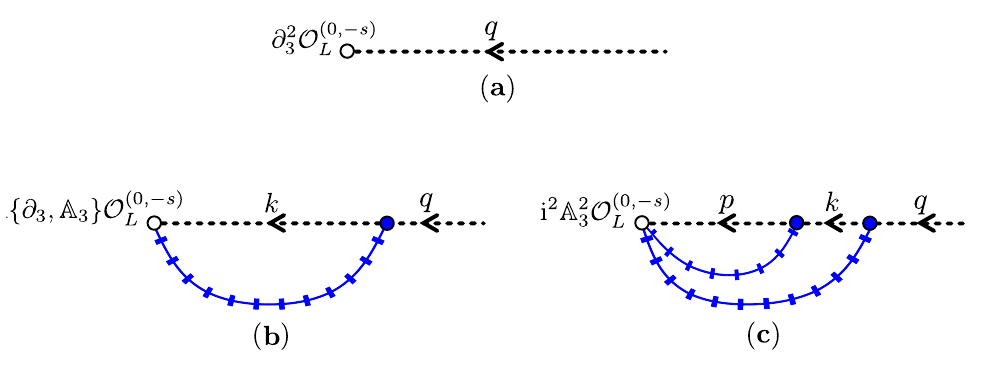
. Here, the gauge field is δ 2 3 O (0 , − s ) L (cid:0) (cid:1) + (cid:0) (cid:1) A A = ∂ . O L A 3 ∂ 3 O L 3 , 3 }O L 3 3